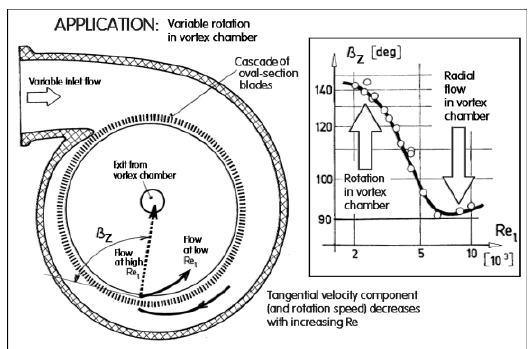
Fig. 22. An application of the investigated variations of the exit angle. The fluid enters the vortex chamber past the cascade and its varying flow direction may be arranged to keep a constant pressure difference across the device in spite of varying flow rate.